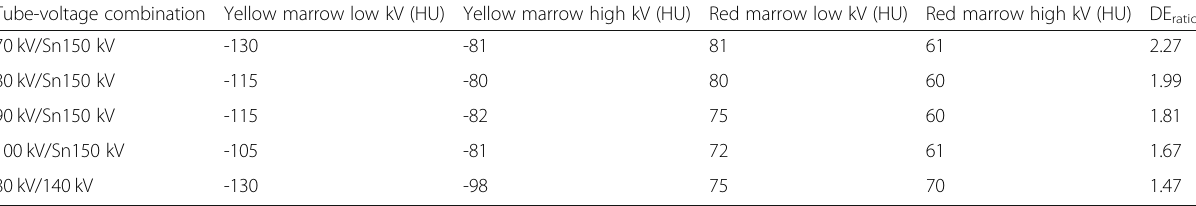
For each tube-voltage combination, the Hounsfield units for the yellow marrow and red marrow were measured. The dual-energy ratio which yielded the lowest mean error was then determined empirically and is used as a measure of spectral separation. Spectral separation increases when the difference in tube voltage is larger or when the tin filter is used; DE ratio dual-energy ratio; HU Hounsfield units; Sn indicates the use of a 0.6-mm tin